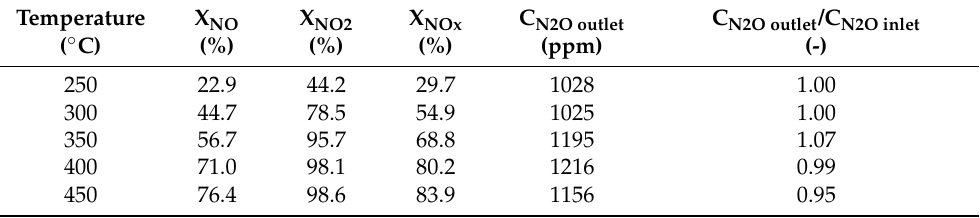
Table 3. NO, NO 2 , total NO x conversion (X) and N 2 O concentrations obtained for Fe-Clin-I.